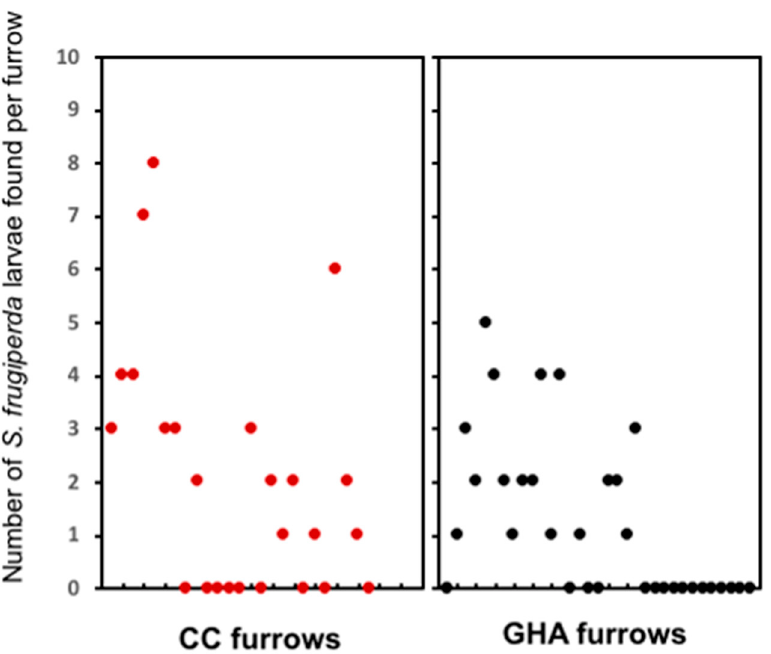
Figure 7. Presence of S. frugiperda in the field trial experiment 1. There were found 52 total larvae in CC furrows and 40 total larvae in GHA furrows. As insects’ distribution appeared to be related to the location of the plants, the frequency of larvae found per furrow is presented. 25 CC furrows = Negative control plants. 33 GHA furrows = B. bassiana strain GHA with methylcellulose treated plants. The analysis GLM-fitted with negative binomial distribution showed Pearson chi-square value of 0.311, indicating the goodness of fit of the data. The Omnibus test value of 0.539 indicated a non-statistically significant model. The Type III Test of Model effects showed p = 0.342 for the treatments (CC/GHA). Table 2. Average weight and length of corn cobs obtained at harvesting